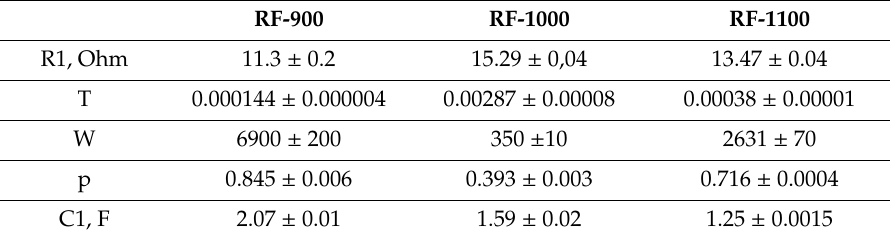
Table 2. Adjusted equivalent scheme parameters for samples, prepared at di ff erent temperature